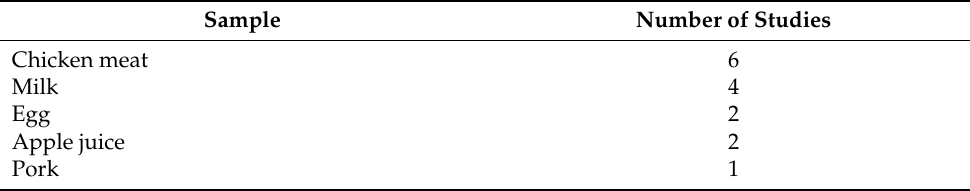
Figure 2. Salmonella serovars involved in the development of electrochemical aptasensors in 15 studies. Table 2. Sample matrix for detection of Salmonella using electrochemical aptasensor platform.